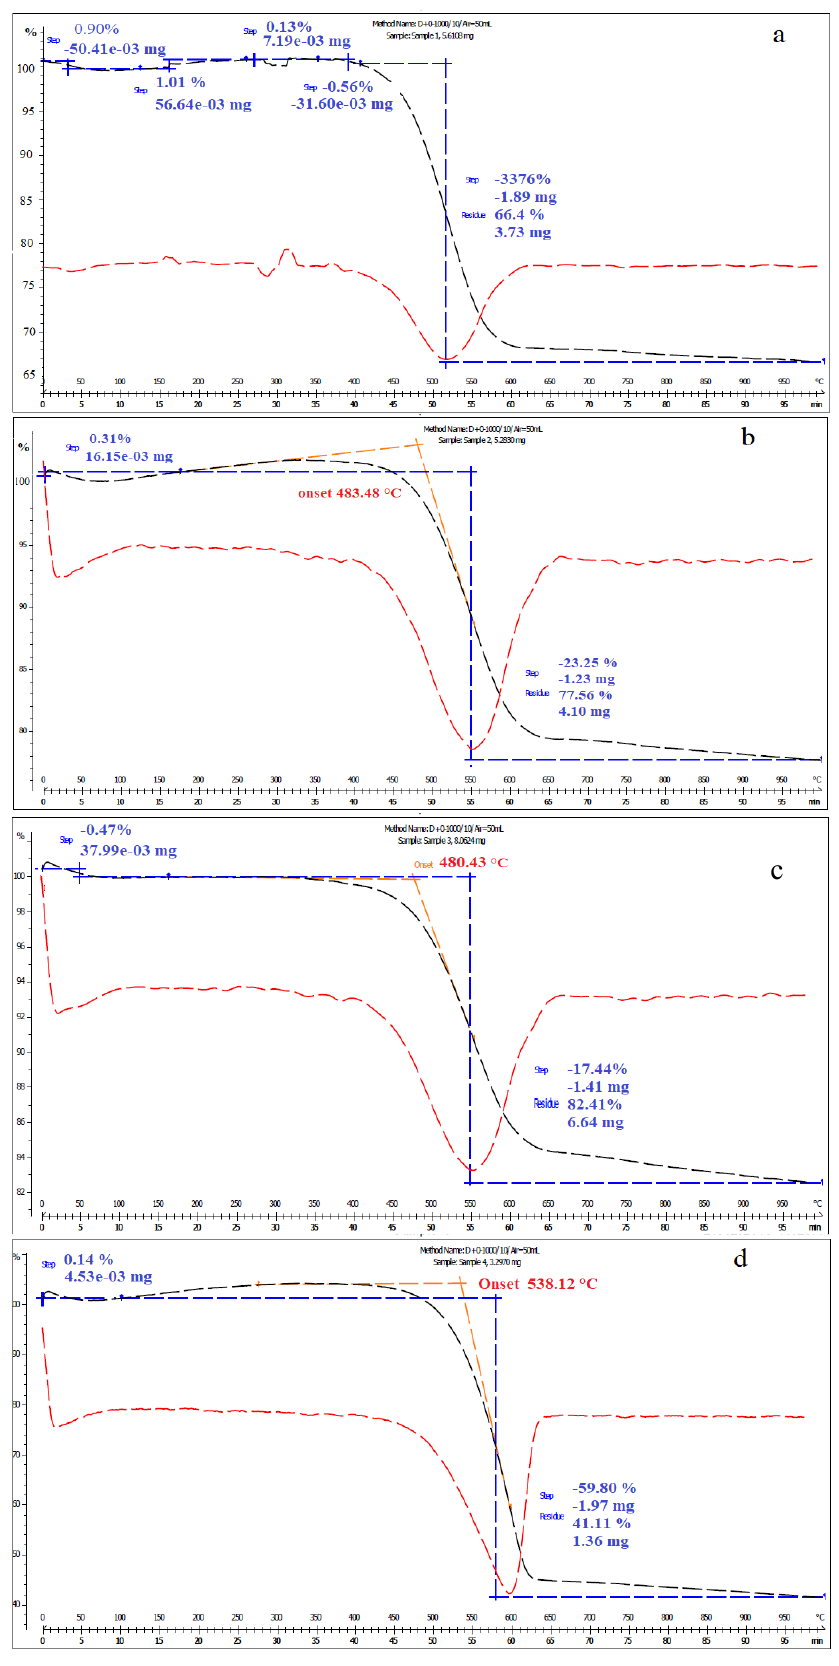
Figure 5. TGA curves of ( a ) Fe 3 O 4 /AC and Fe 3 O 4 /AC/TiO 2 in ratios of ( b ) 1:1, ( c ) 1:2, and ( d ) 1:4 in an air atmosphere.